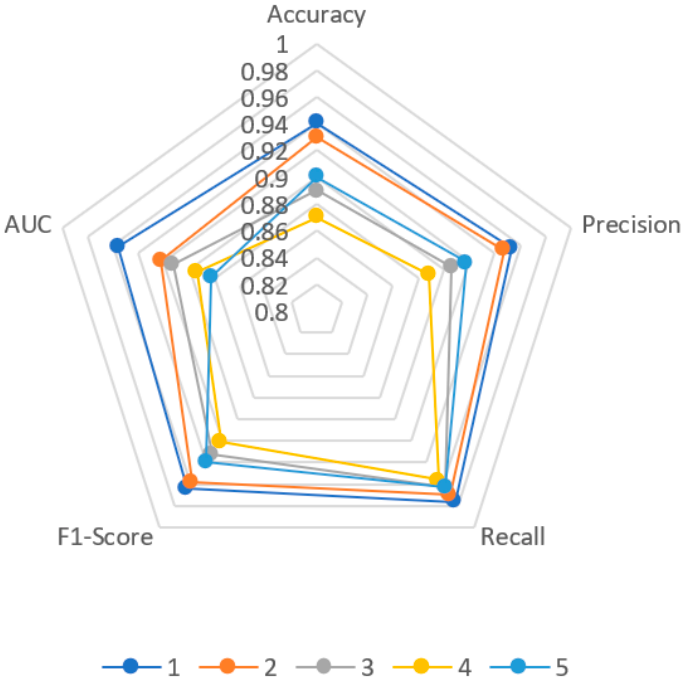
Figure 15. Evaluation of abnormal detection results of different radar.